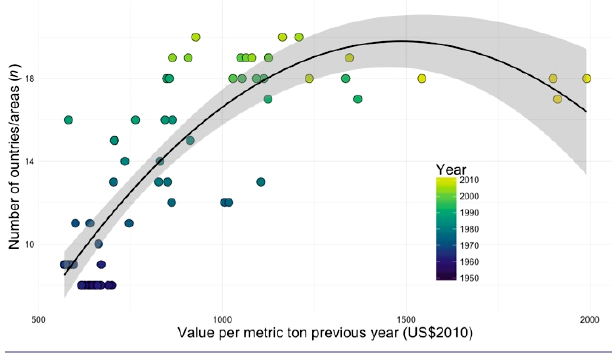
Fig. 2 . Geography of global sea cucumber exploitation. Fig. 3 . Visual representation of model 4a. Year (the general time variable) is incorporated through use of color to fill dots representing each